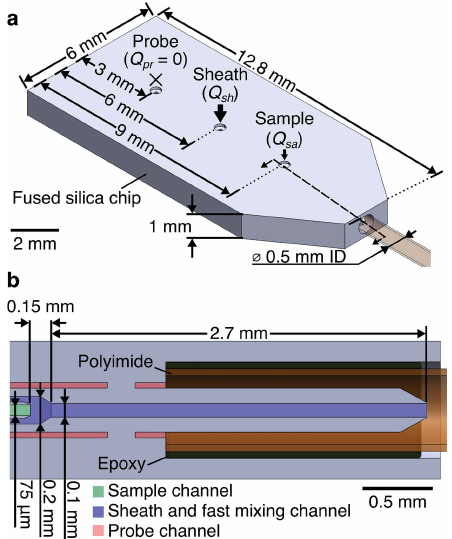
Figure 9 CAD-renderings of microfluidic mixer. ( a ) Isometric view of fused silica chip-polyimide capillary subassembly with key dimensions labeled. The three inlets to the chip are labeled. ( b ) Cross-sectional view at the location of the dashed line in ( a ). The three channels inside of the fused silica chip are highlighted for